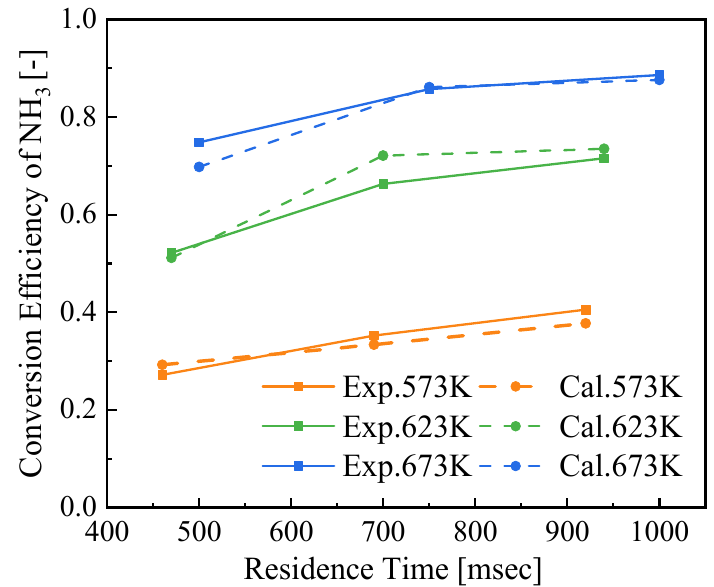
Figure 3. The comparisons of the experimental and simulated NH 3 conversion efficiency at different exhaust gas temperatures.